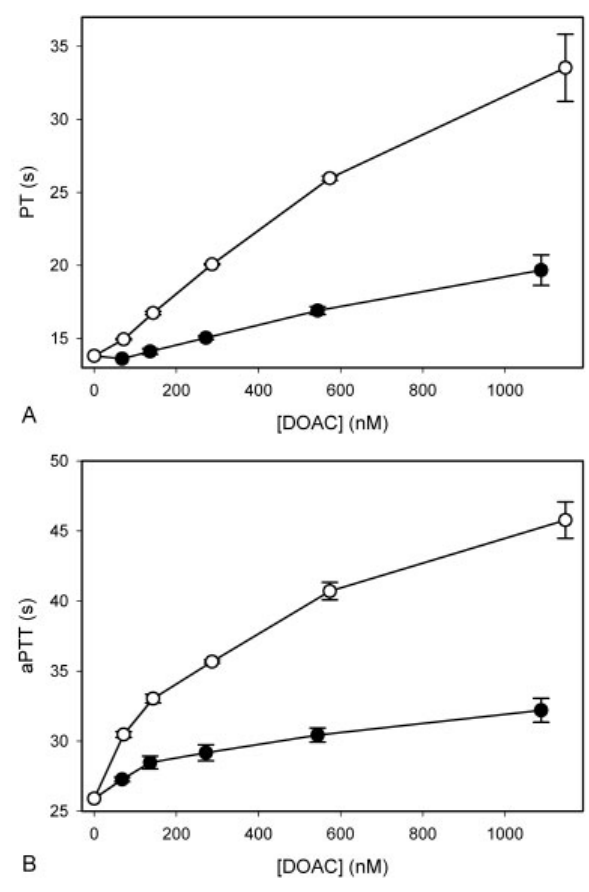
Fig. 1 Comparison of the effects of rivaroxaban and apixaban on the prothrombin time (PT) and activated partial thromboplastin time (aPTT). The ( A ) PT and ( B ) aPTTwere determined inhuman plasmain the presence of increasing concentrations of apixaban ( closed ) or rivaroxaban ( open ). Symbols re fl ect the mean (cid:3) SD of four